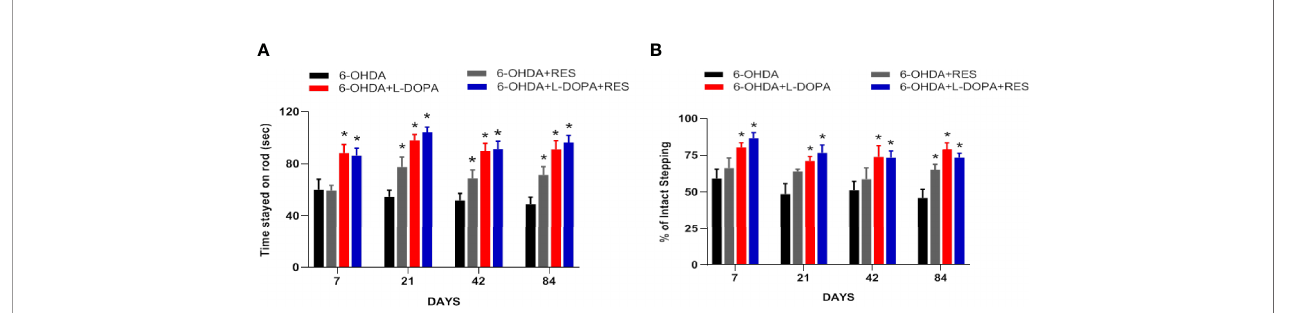
FIGURE 2 | RES didn ’ t affect L-DOPA ’ s anti-PD ef fi cacy. The bene fi cial effects generated by co-treatment of RES with L-DOPA on 6-OHDA-induced rat behavior changes were analyzed by rotarod test (A) . The time rat stayed on the rod was recorded. The effects of RES together with L-DOPA on forelimb stepping changes were determined via the stepping test to further evaluate whether RES affected L-DOPA ’ s ef fi cacy (B) . Data were expressed as mean ± SEM from 10 rats. * P < 0.05 compared with 6-OHDA group.